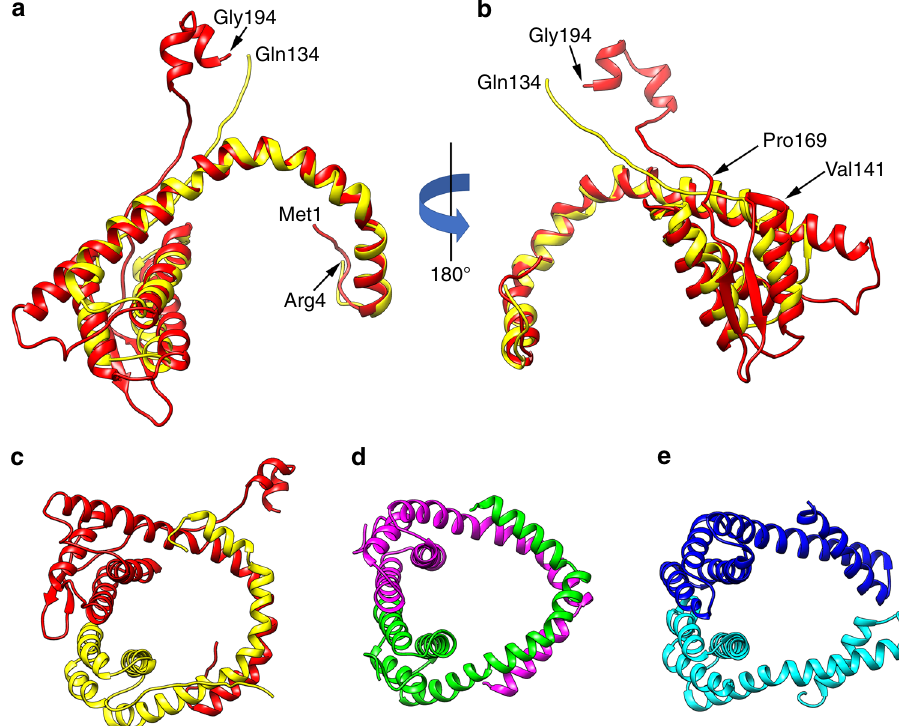
Fig. 6 Structural conservation and divergence among capsid proteins. Heterodimers ( a , b , c , e ) and homodimers ( d ) form the capsids in SFV1 ( a , b , c ), SIRV2 ( d ) and AFV1 ( e ). a , b VP5 (red) and VP4 (yellow) from SFV1 have been aligned to each other. The long α -helix that wraps around the DNA is structurally quite conserved between the two. The main differences between the two coat proteins is that VP5 has an insert (from ∼ 141 to 169) that contains the two β -strands seen in ( b ), and VP5 has a C-terminal extension that contains two short helices. This C-terminal extension crosses the helical groove and makes a large contact with a subunit in the next turn. The SFV1 heterodimer ( c ) is more similar in how it wraps DNA to the SIRV2 homodimer ( d ) than it is to the AFV1 heterodimer ( e